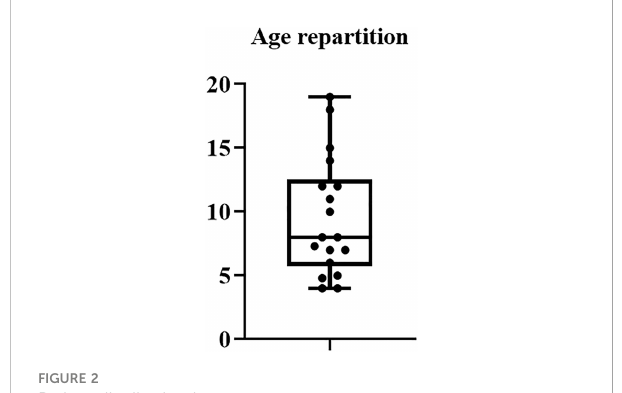
FIGURE 2 Patient distribution by